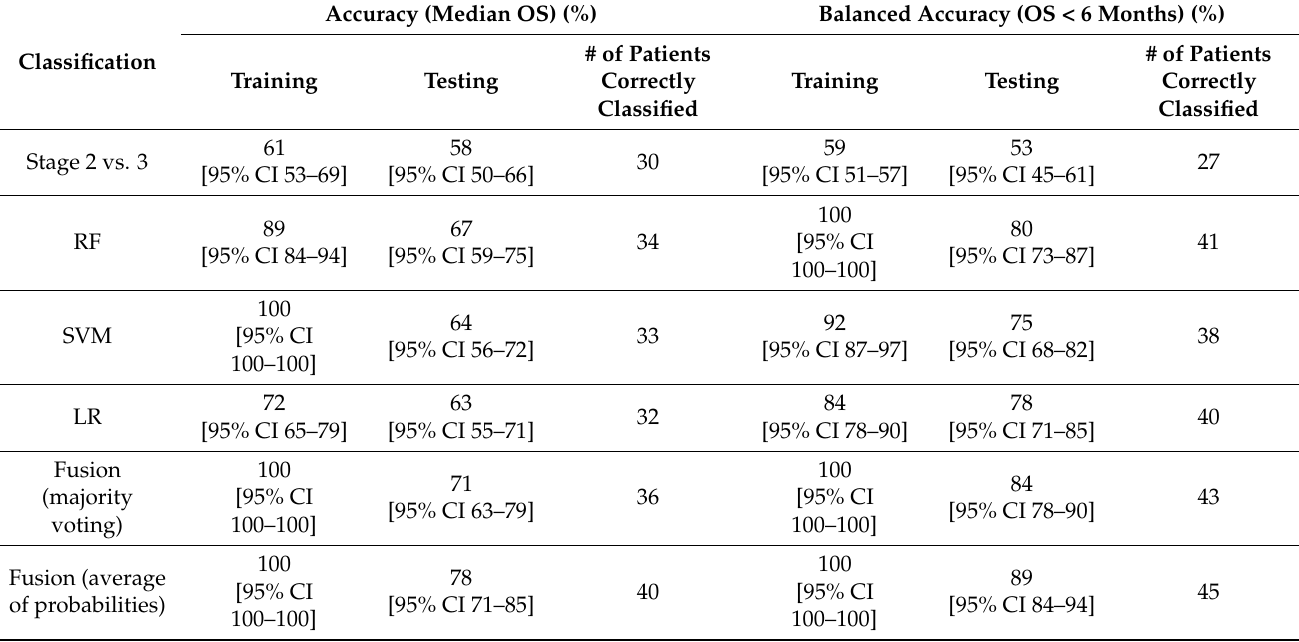
Table 2. Performance of the various ML methods and their